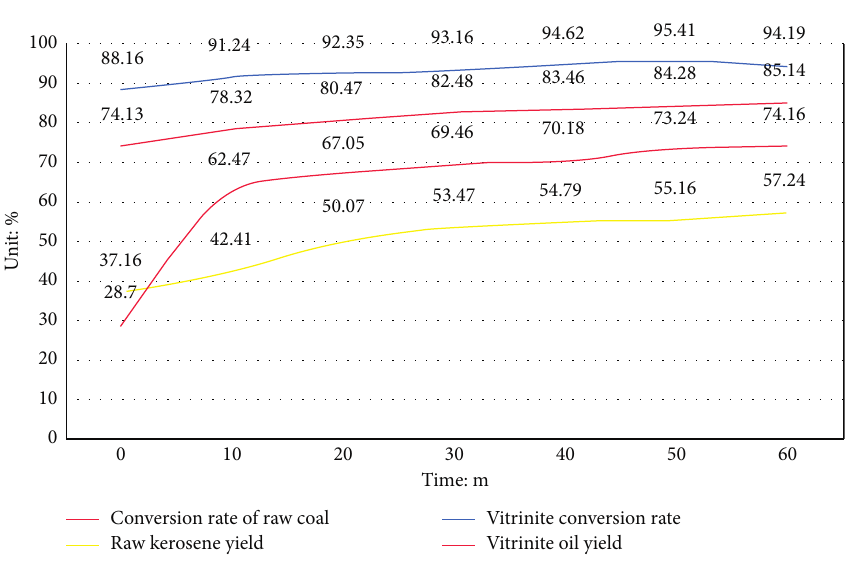
Figure 4: Liquefaction conversion rate and oil yield of raw coal and its vitrinite.